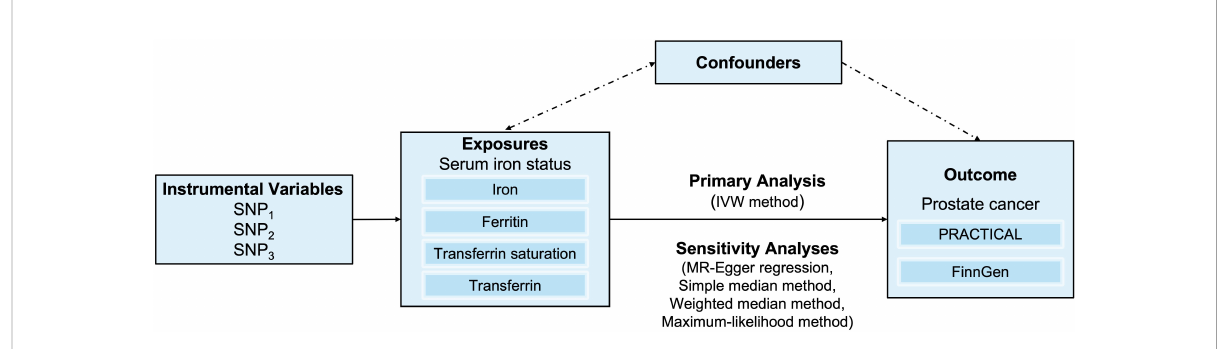
FIGURE 1 An overview of the study design. Abbreviations: IVW, inverse-variance weighted; SNP, single-nucleotide polymorphism. PRACTICAL, Prostate Cancer Association Group to Investigate Cancer Associated Alterations in the